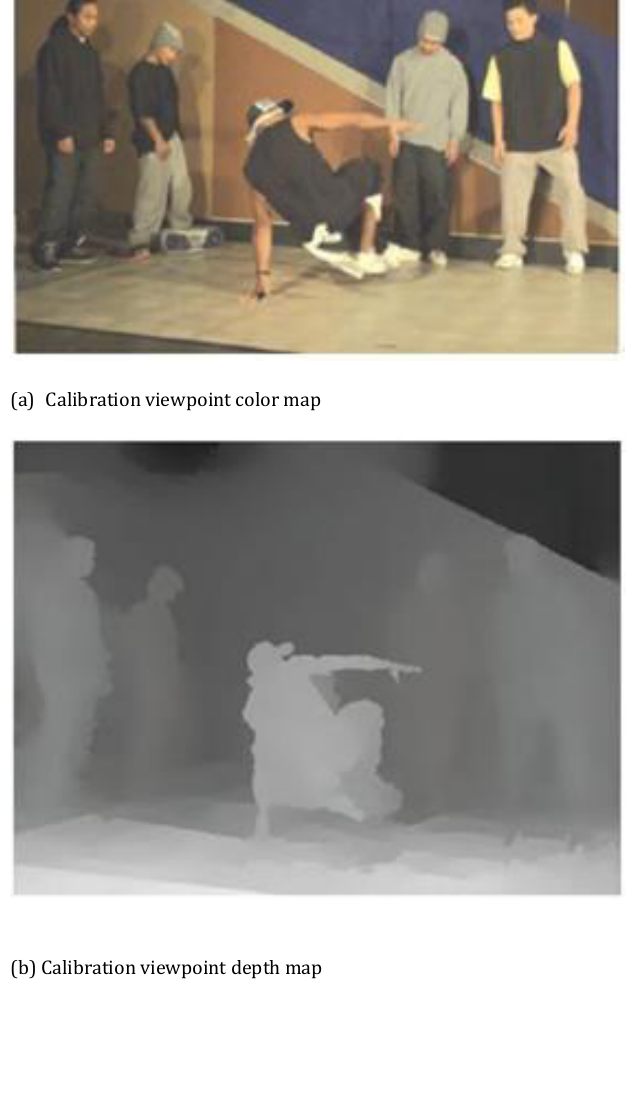
Figure 2: Algorithm flow of the proposed